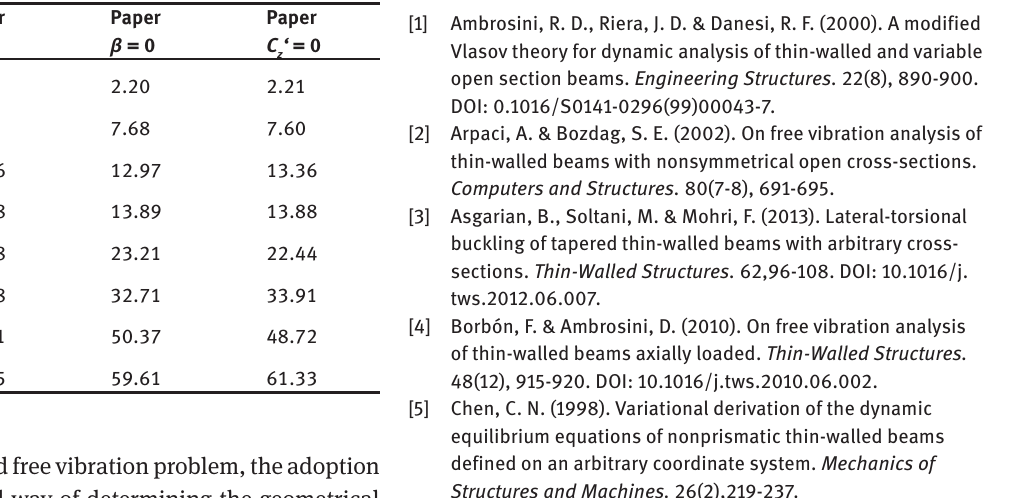
Table 4: Eigenfrequencies for different models in case of clamped- free support (C-F)